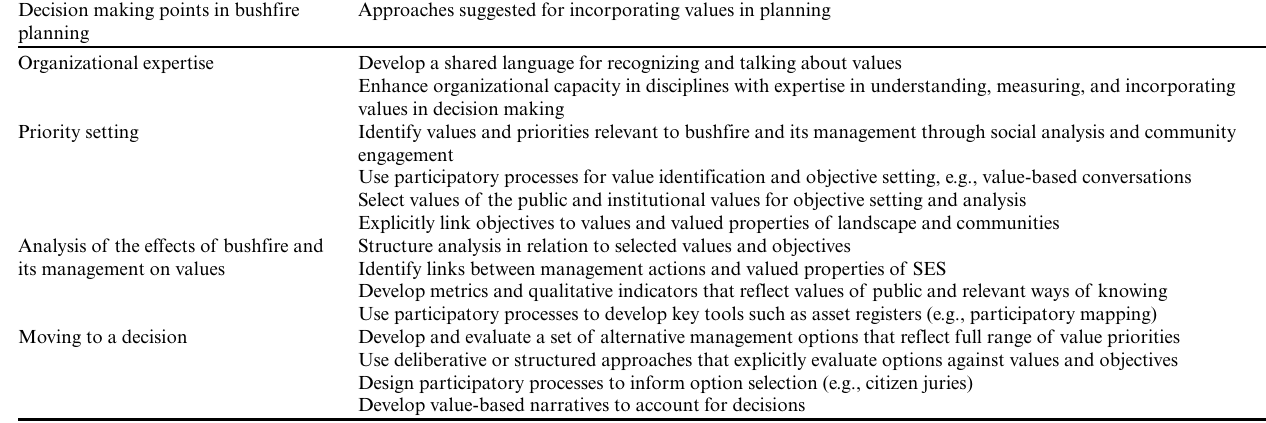
Table 2. Potential approaches for incorporating values in bushfire risk planning in Victoria. Approaches were identified by DELWP staff and researchers through collaborative research conducted during 2015–2017. During workshops and meetings and document reviews, agency staff were asked to identify ways new knowledge about values could be practically applied in their work Decision making points in bushfire Approaches suggested for incorporating values in planning planning Organizational